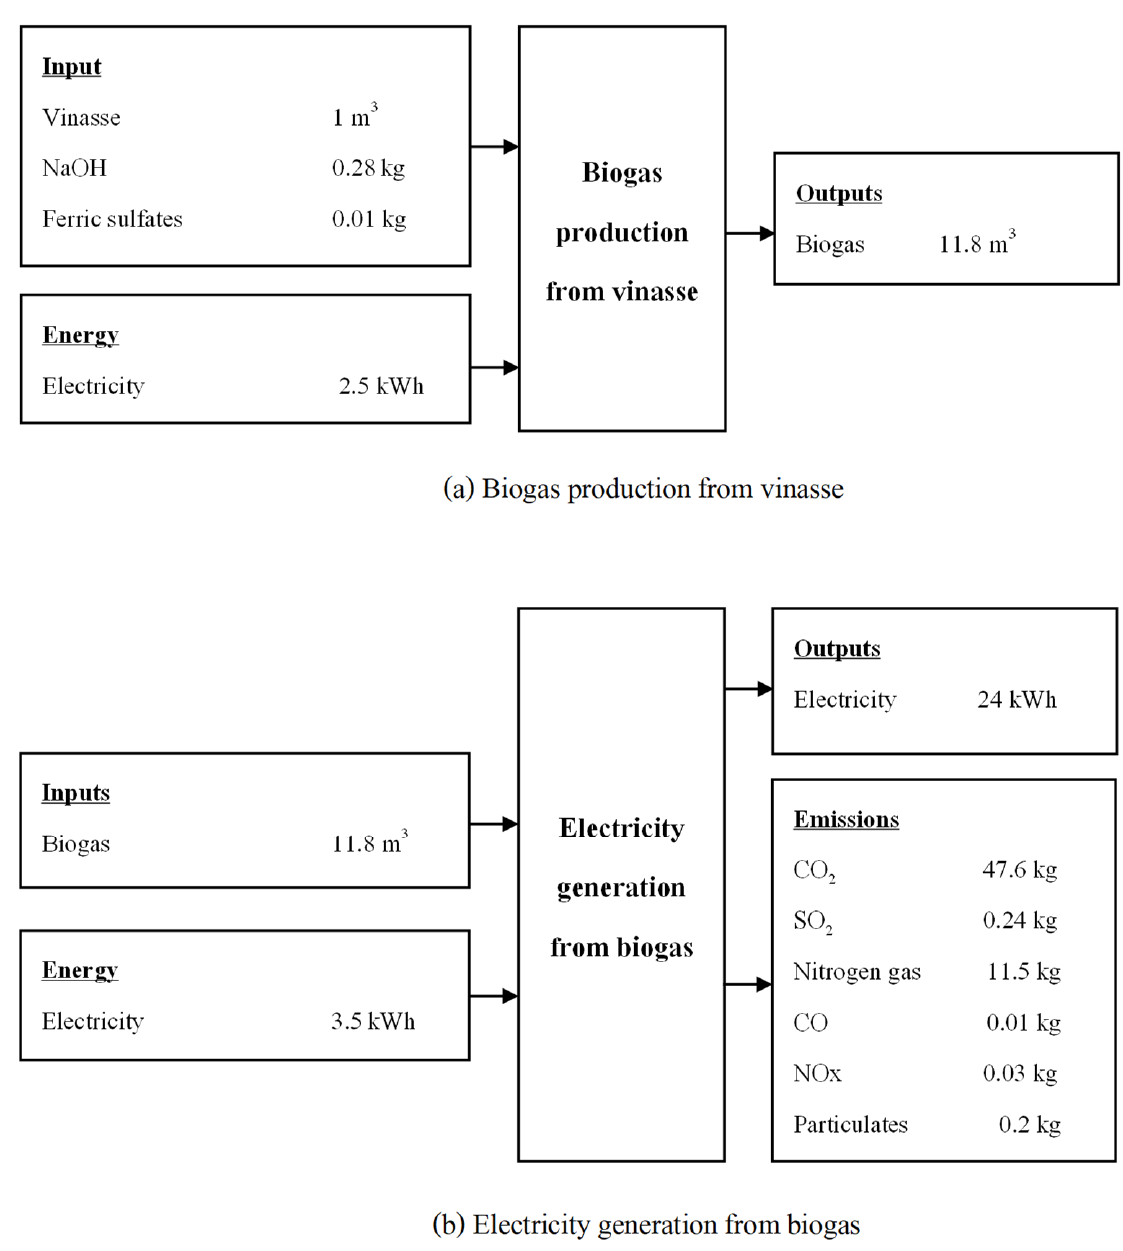
Figure A7. Inputs-Outputs of Scenario V2: Vinasse for biogas and power generation (V2). Remark: Production data is referred from [57].